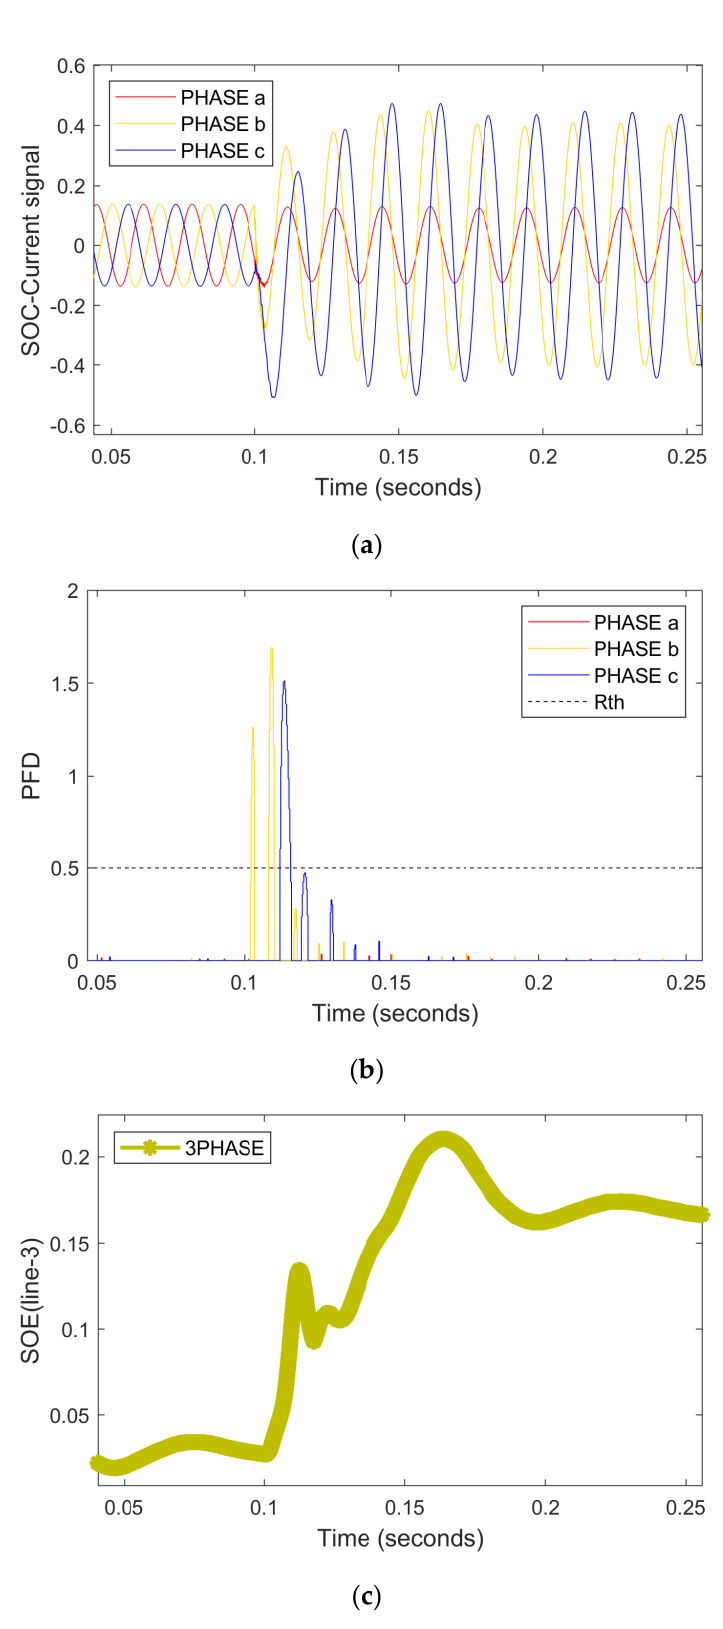
Figure 9. An HI double line-to-ground fault with Z L = 80 Ω hits phase B and C in IN mode. ( a ) Current signals ( b ) PFD ( c ) RNN-assisted SOE.